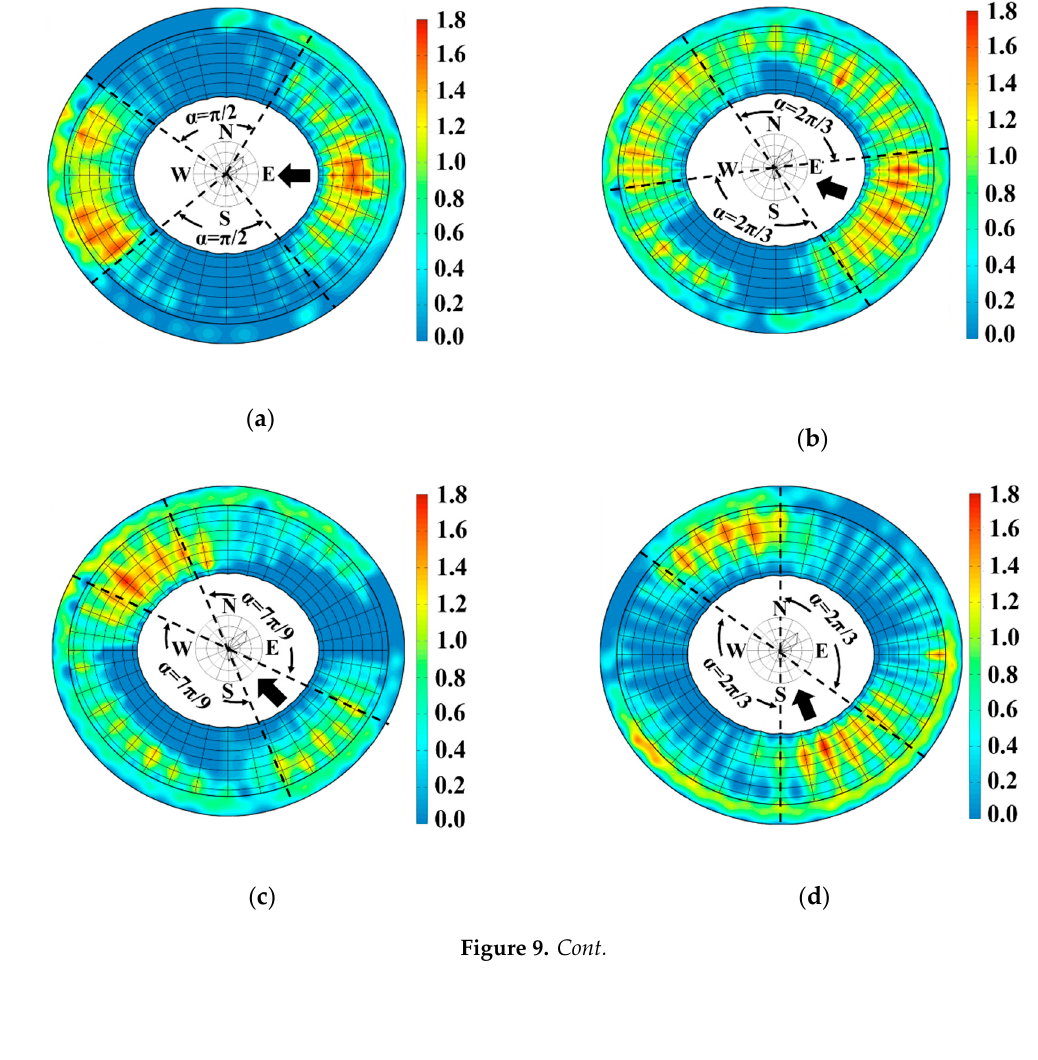
( e ) Figure 9. Snow distribution shape coefficient μ : ( a ) 0°; ( b ) 22.5°; ( c ) 45°; ( d ) 67.5°; and ( e ) 90°. ( a ) ( b ) Figure 10. Unbalanced distributed shape coefficient on building roofs: ( a ) shape coefficient for umbrella-shaped roof indicated in the technical specification for cable structures; ( b ) shape coefficient for multi-span gable roof indicated in load code for design of building structures. 4. Analysis of Snow Distribution Characteristics 4.1. Analytical Method To deeply analyze the relationship between the snow distribution pattern and the shape characteristic of the roof, the empirical orthogonal function (EOF) analysis was adopted. This approach is generally used to analyze the structural features in data and extract major data feature quantities. Specifically, EOF analysis can decompose a variable field matrix X that changes with time into a time-independent spatial matrix EOF and a time matrix PC , as shown in Equation (9).